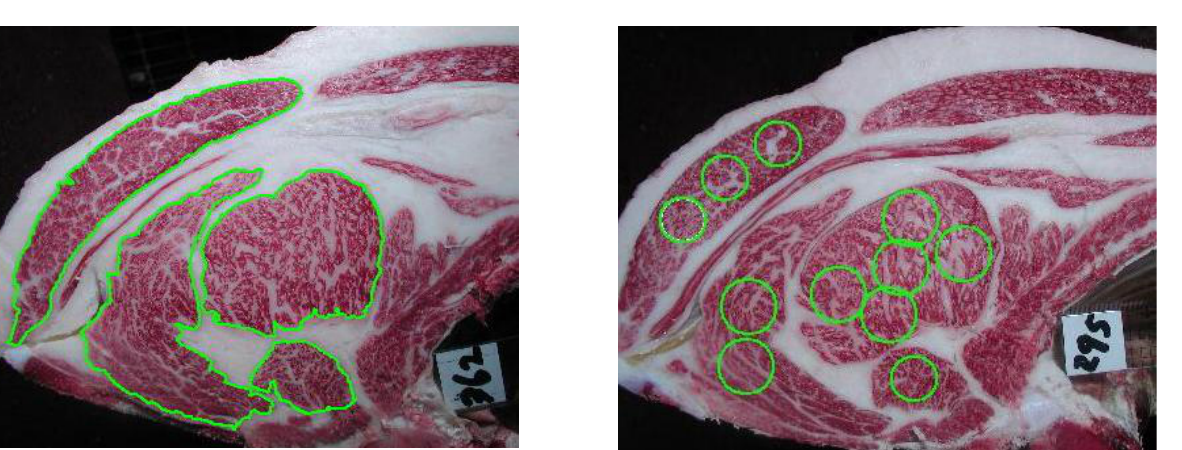
Figure 2. Spot method by image analysis. The areas were selected speedy in 3 and 2.5 centimeters in diameter for longissimus thoracis, trapezius, semispinalis dorsi and semispinalis capitis